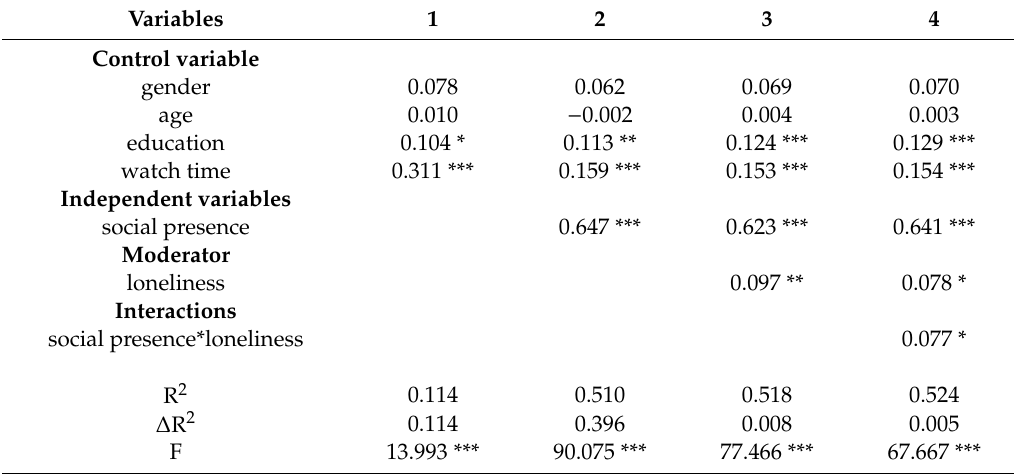
Table 5. Loneliness, social presence and flow experience structure.